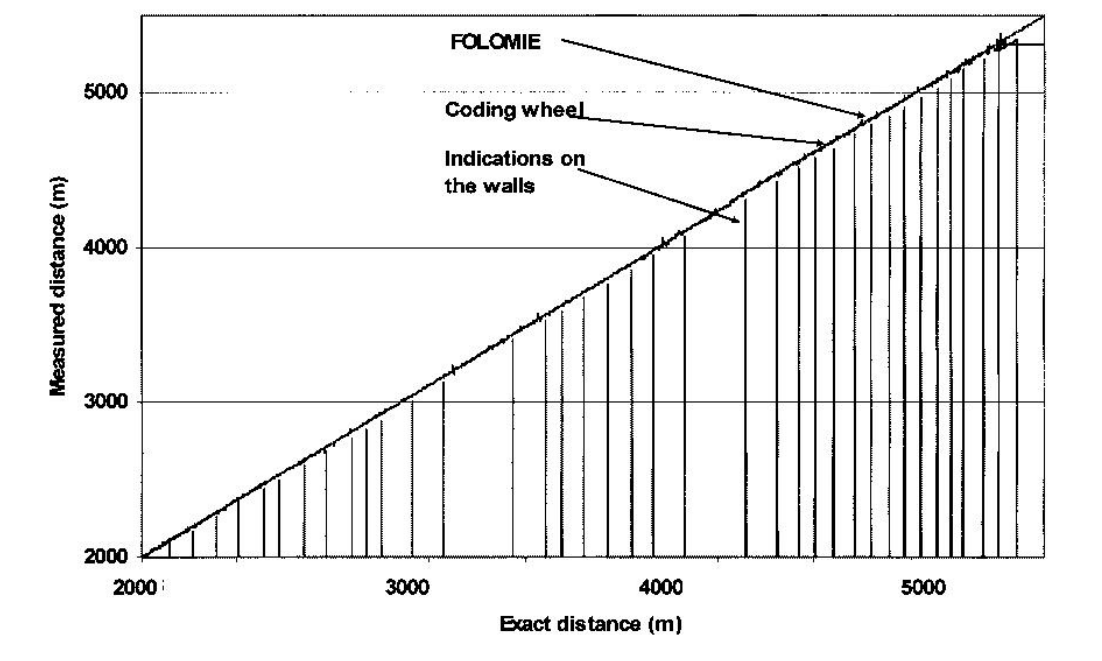
Figure 4. Measured distance versus “exact” distance. Comparison between the FOLOMIE results to those given by the coding wheel or by indications on the